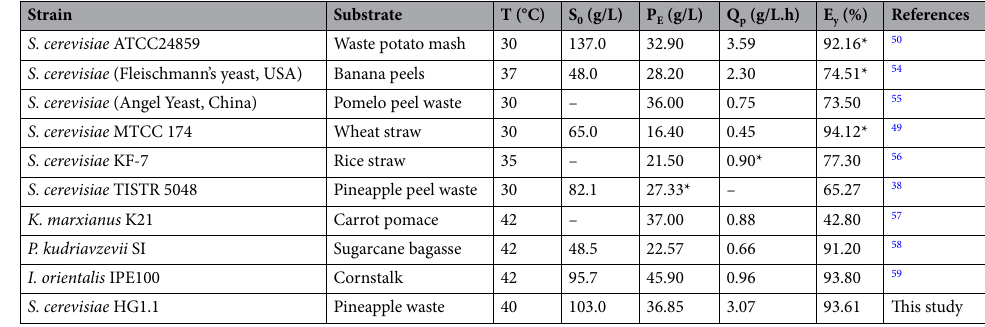
Table 10. Comparative study on ethanol production from waste hydrolysate using S. cerevisiae and other yeast strains. T: temperature; S 0 : initial sugar concentration; P E : ethanol concentration; Q p : ethanol productivity; E y : yield efficiency; *: calculated by the authors (not given directly in the reference); –: not determined in the referenced study.